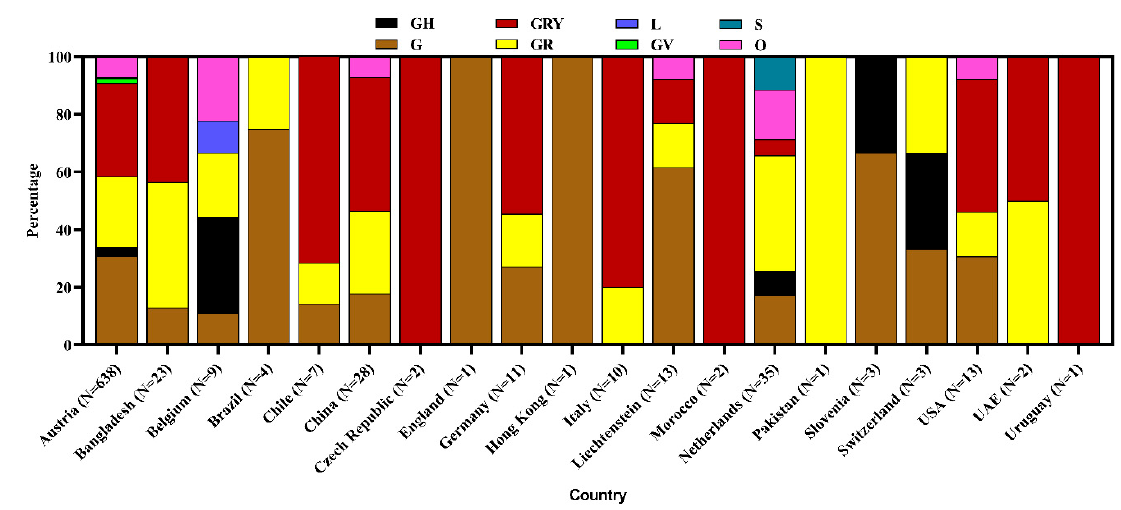
Figure 5. Clade diversity of SARS-CoV-2 isolated from environmental sampling.